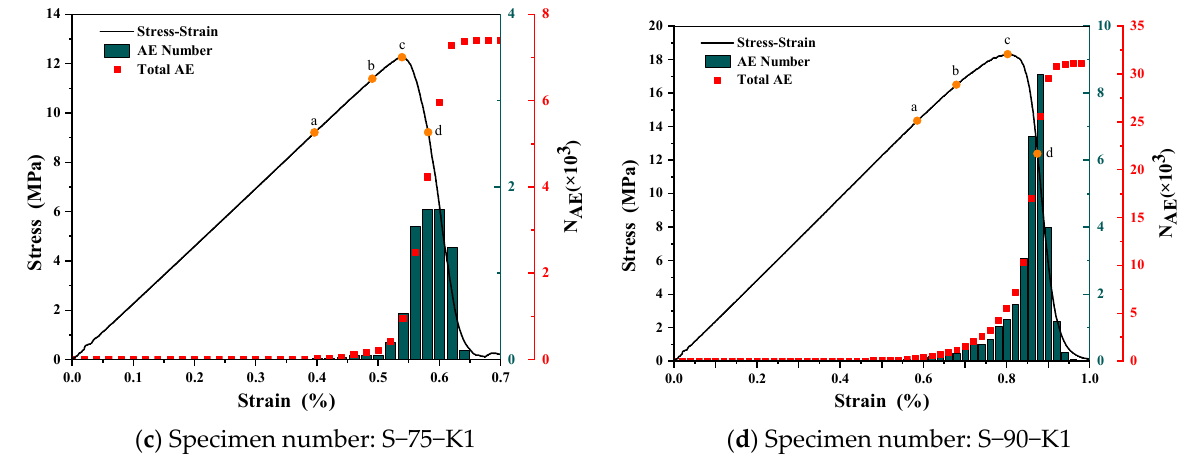
Figure 9. Evolution of the load, AE count rate and cumulative AE count of sandstone over time. The particle flow simulation can monitor and count the damage evolution of micro- cracks in the fracture process. Figures 10–12 show the damage evolution process of the nonpersistent jointed rock mass with different inclinations. For each specimen, four points a, b, c, and d (which correspond with Figure 9) were recorded to analyse the microcrack accumulation and macrocrack growth during loading. For the specimen in the splitting failure mode (specimen S − 0 − K1), the damage evolution process is shown in Figure 9a–d. As shown in Figure 10a,b, before peak stress, crack initiation occurs randomly inside the specimen. Although there are many internal microcracks, no visible macroscopic fracture surface is found. When loading reaches point c, as the crack further develops, the cracks are densely generated on the outer edge of the joint, forming a damage zone (Figure 10c). As the loading continues, at point d, many microcracks gather inside several rock bridges, which indicates that these rock bridges are fractured. Additionally, the splitting failure surface is derived from the boundary position of the rock bridge.